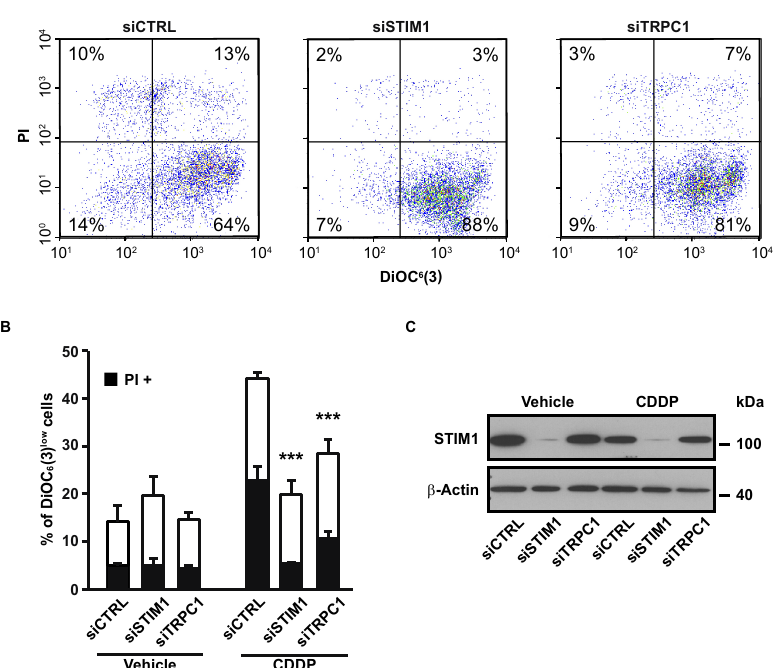
Figure 2. Effects of STIM1 and TRPC1 depletion on apoptosis-associated mitochondrial Figure 2. E ff ects of STIM1 and TRPC1 depletion on apoptosis-associated mitochondrial transmembrane transmembrane potential (ΔΨ m ) dissipation and plasma membrane permeabilization. ( A ) Following potential ( ∆Ψ m ) dissipation and plasma membrane permeabilization. ( A ) Following transient transfection (for 72 h) with either siRNA downregulating STIM1 (siSTIM1) or TRPC1 (siTRPC1) or with a control siRNA (siCTRL), A549 cells were left untreated or treated for additional 24 h with 25 µ M CDDP, and labeled for the cytofluorometric assessment of ∆Ψ m [with the ∆Ψ m -sensitive probe DiOC 6 (3)] and plasma membrane integrity (with propidium iodide, i.e., PI). ( B ) Quantification of data presented in A. White and grey columns represent the percentage of cells exhibiting ∆Ψ m loss alone [DiOC 6 (3) low ] or in association with plasma membrane breakdown (PI + ), respectively. Data are means of triplicate experiments ± S.D. and are representative of three independent experiments. Student’s t test was employed to assess statistical significance. *** p < 0.001. ( C ) Immunoblot analysis of STIM1 expression 96 h after transfection of A549 cells with siCTRL, siSTIM1 or siTRPC1. β -actin was used as loading